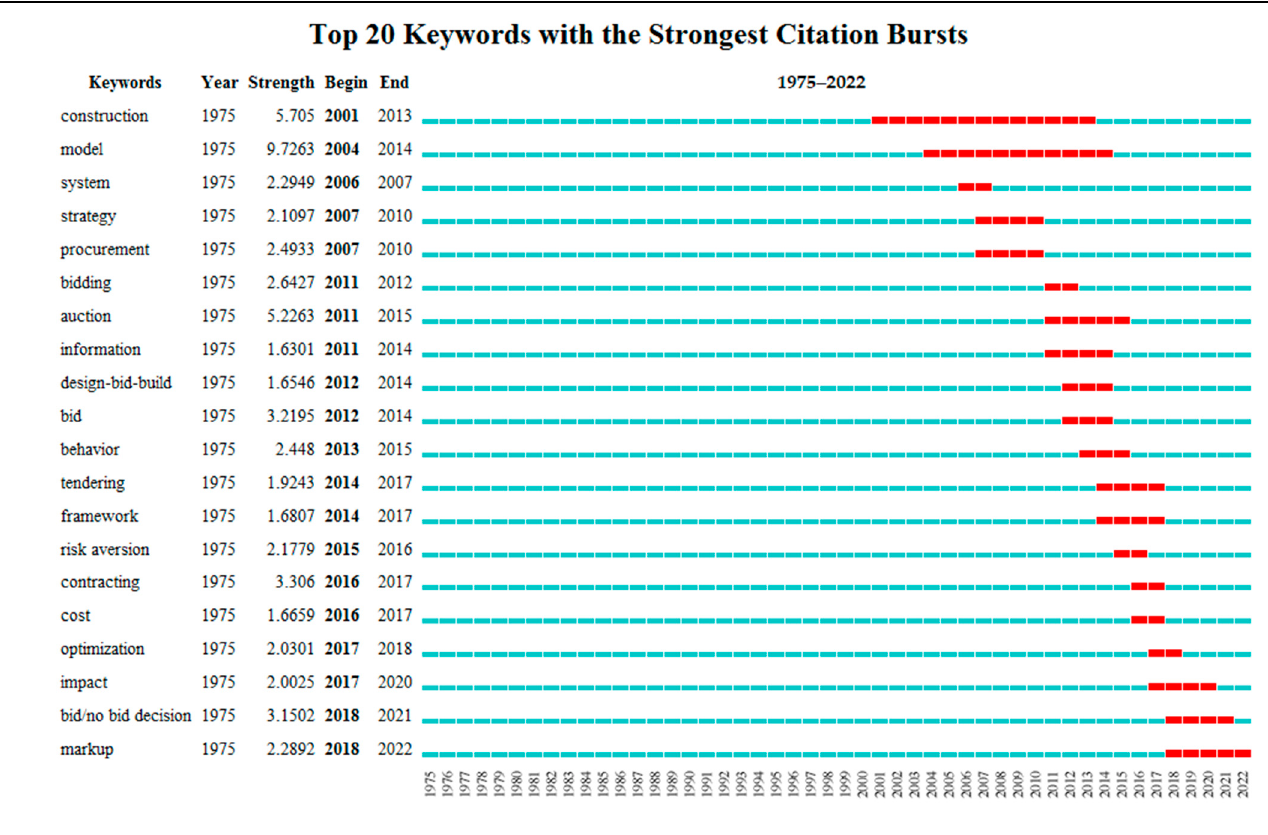
Figure 5. Top 20 keywords in construction bidding with the strongest citation burst.